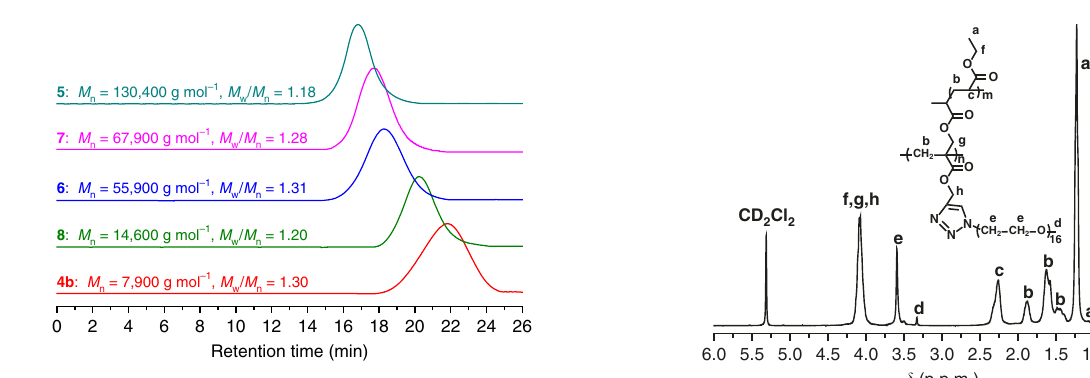
Fig. 5 Molecular weight of precursor and double-brushes. GPC traces of PBAA 4b macro-agent, PA- g -PEA/PEO 5 , PA- g -PDMAEA/PEO 6 , PA- g - PS/PEO 7 and PA- g -PPFMA/PEO 8 asymmetric molecular double-brushes in tetrahydrofuran (THF)